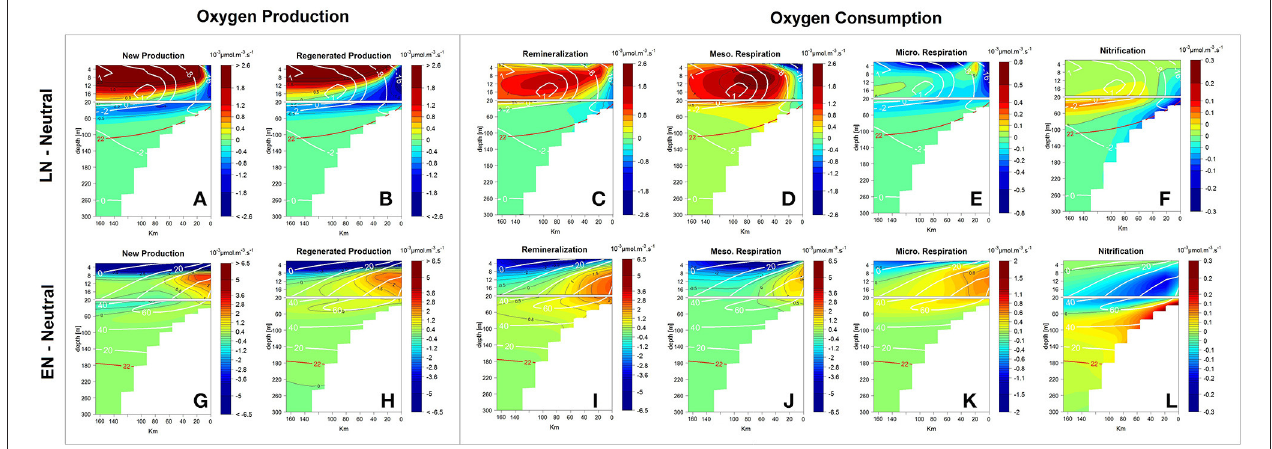
FIGURE 10 | Alongshore-averaged vertical sections of DO anomaly sources (by new and regenerated production) (A,B,G,H) and sinks (remineralization, respiration by zooplankton and nitrification) (C–F,I–L) in 10 − 3 µ mol O 2 m − 3 s − 1 during LN (Top) and EN (Bottom) periods. The sign of the sink terms has been changed to positive in this figure. DO anomalies (white lines) and the isoline of 22 µ mol O 2 kg − 1 (red lines) are presented.